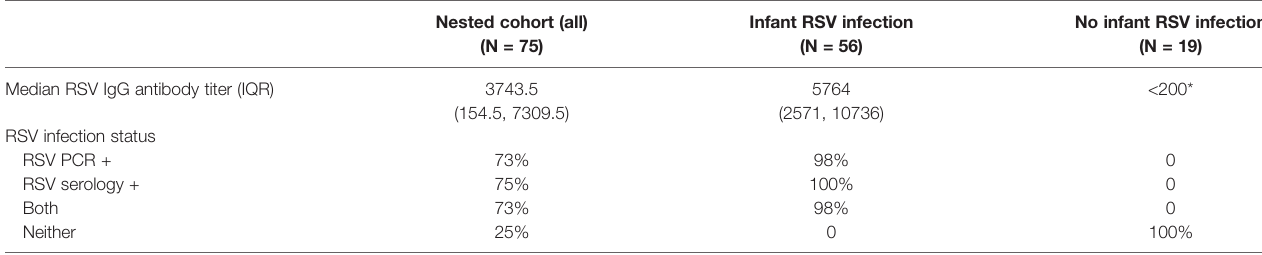
TABLE 2 | Infant RSV infection status of children in nested cohort.